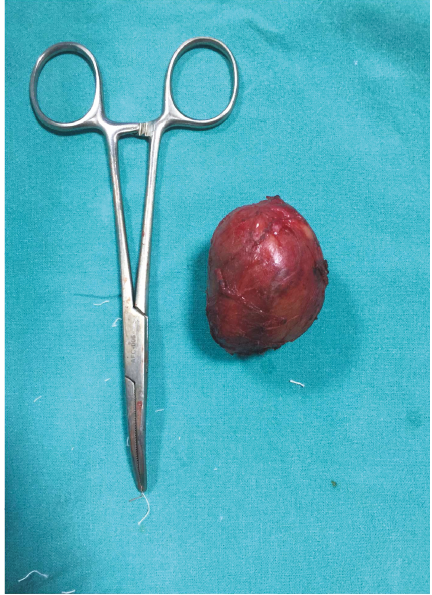
Figure 4: Well-circumscribed tumor with smooth